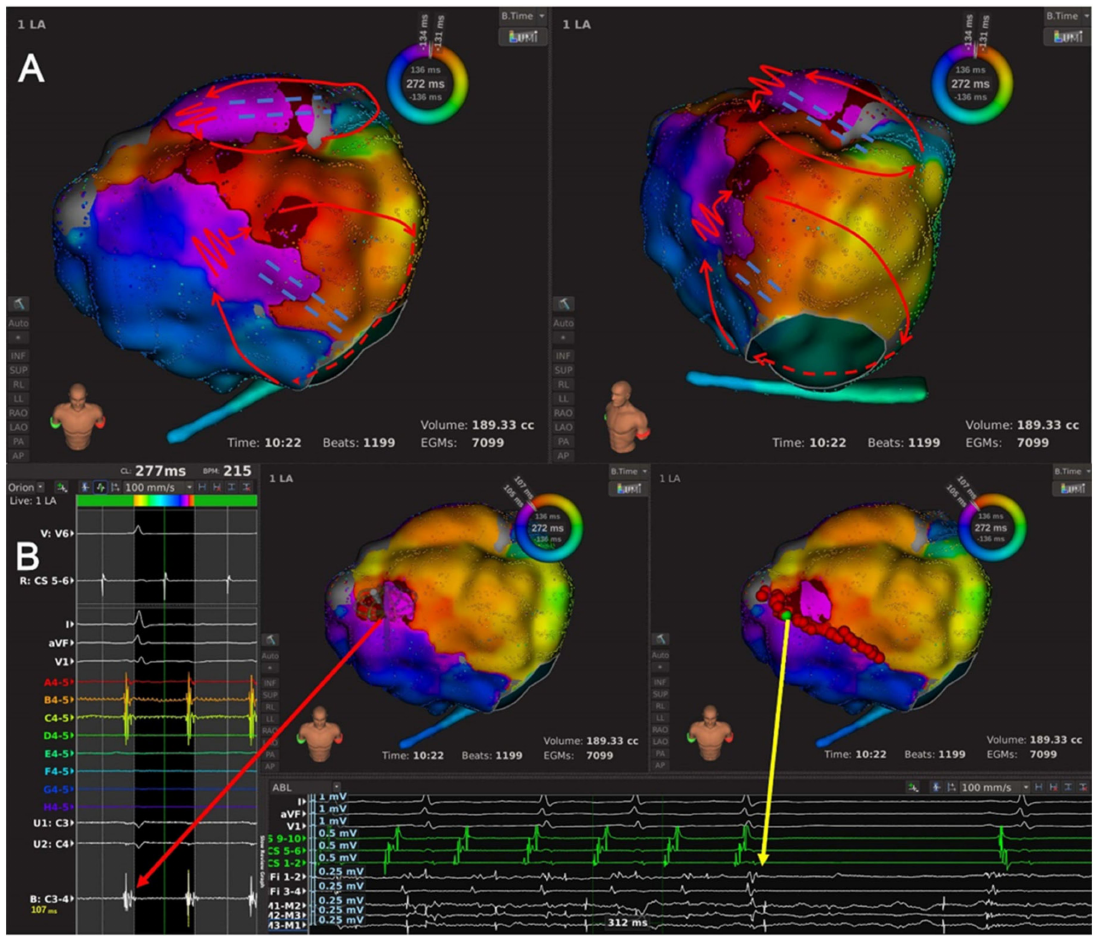
Figure 4. The high-density mapping of a Type 1.3 AT. ( A ) Activation map of a Type 1.3 AT from the anteroposterior view with additional cranial tilt (left) and the left-anterior oblique view with additional cranial tilt (right). The LA high-density mapping identified two block lines, including one LAAW block line from the RSPV to the MVA and one roof block line between the RSPV and the left superior pulmonary vein (LSPV). Two conduction gaps were identified, including one at the RSPV end of the LA roof line and the other at the RSPV end of the LAAW line. This was a dual-looped AT, and the activation propagated around the LA roof scar and the MVA simultaneously. The wavefront ran in LAAW from the right pulmonary vein antrum toward the LA free wall, turned around the MI and activated the LA posterior wall, and then divided into two branches: (1) the wavefront ran up and propagated along the LA roof line, went across the roof line conduction gap and returned to the LAAW; (2) the wavefront ran around the MVA, propagated upward in the LA septum, went across the LAAW conduction gap and returned to the LAAW. The red lines with arrows indicated the circuit of AT; the dashed red line indicated the circuit of AT behind the atrial structure; the jagged red lines indicated the wavefront passing the slow conduction area; the double-dashed blue lines indicated the LAAW and the roof block of lines. ( B ) Local map potentials of the LAAW gap during AT (left) and at the moment of AT termination (bottom). The red dots indicated the ablation points; the green dot indicated the termination site; the arrowed red and yellow lines indicated the local potentials during AT and at the moment of AT termination,